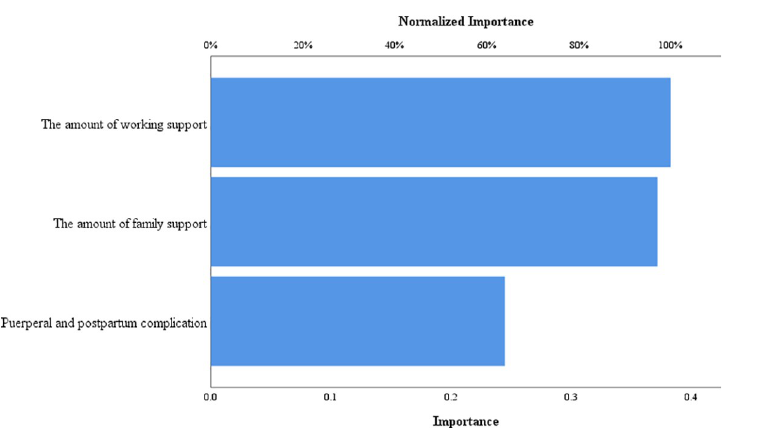
Fig 3. The important grade of